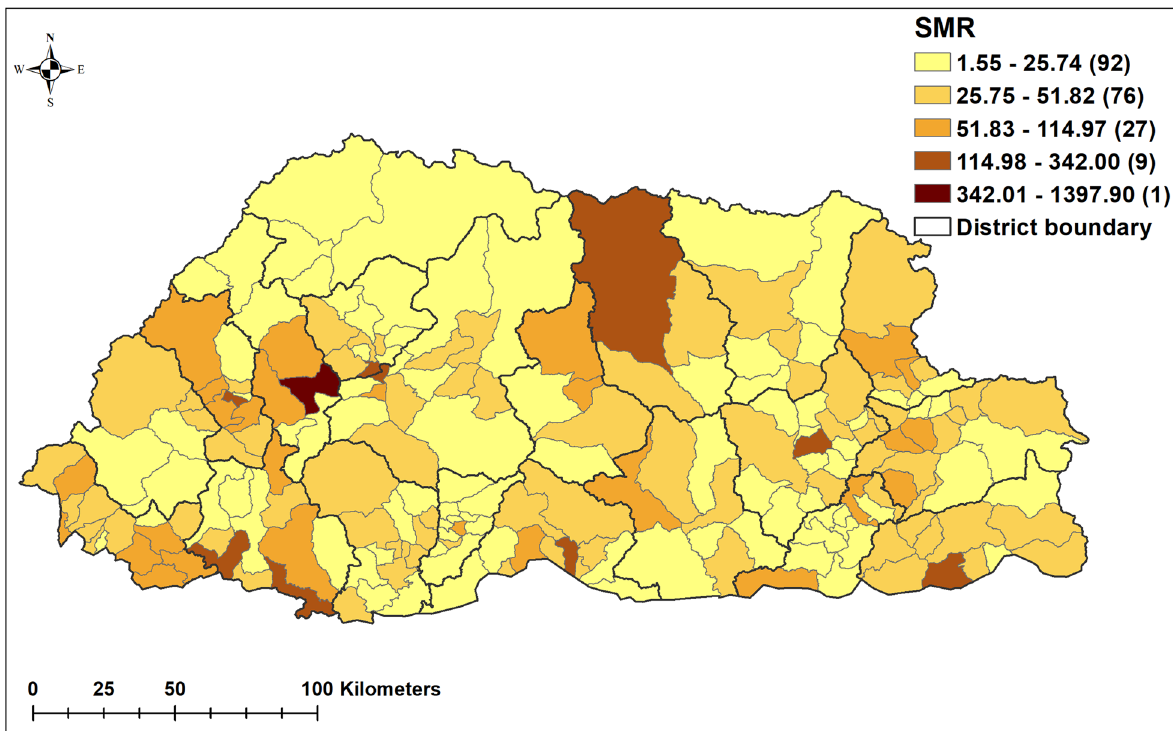
Figure 3. Crude standardized morbidity ratios (SMR) of pneumonia by sub-district during the study period, 2010–2018. (Maps were created using ArcMap 10.5 software (ESRI, Redlands,